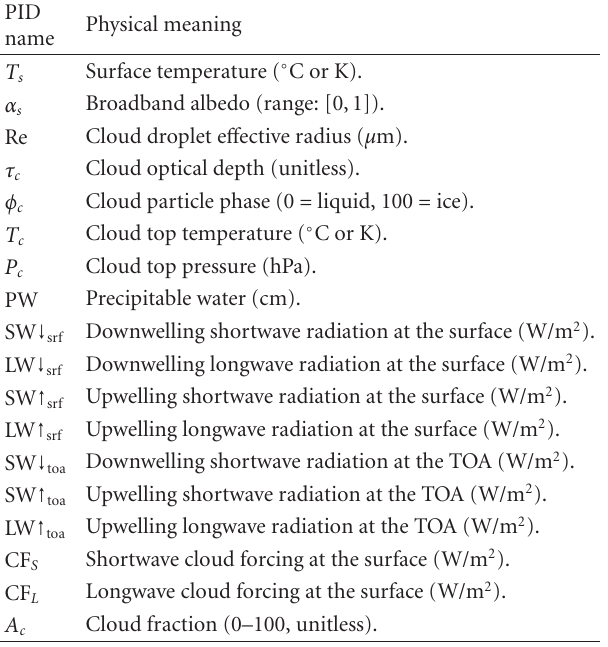
Table 1: Symbols and physical meanings of the 18 retrieved climate